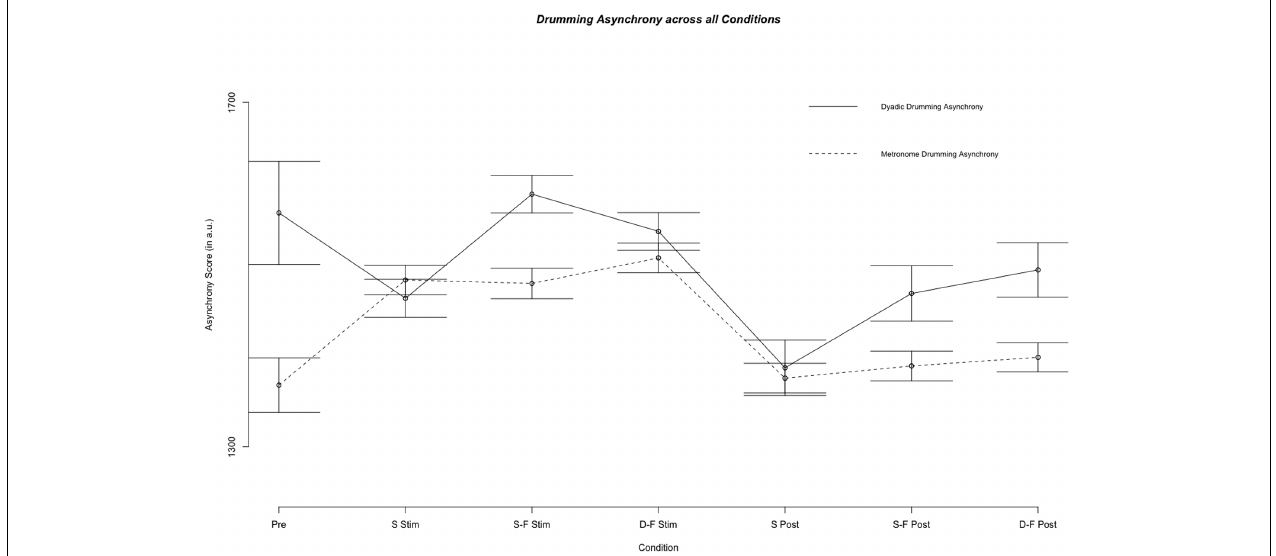
FIGURE 2 | Results of the fixed effect of the linear mixed model analysis for the effect of condition on dyadic and metronome asynchrony scores. Displayed are mean asynchrony scores as estimated by the model. Stimulation conditions: Pre, pre; S Stim, sham stimulation; S-F Stim, same-phase-same-frequency stimulation; D-F Stim, different-phase-different-frequency stimulation; S Post, sham post; S-F Post, same-phase-same-frequency post; D-F Post, different-phase-different-frequency post. Standard errors are indicated by horizontal lines.